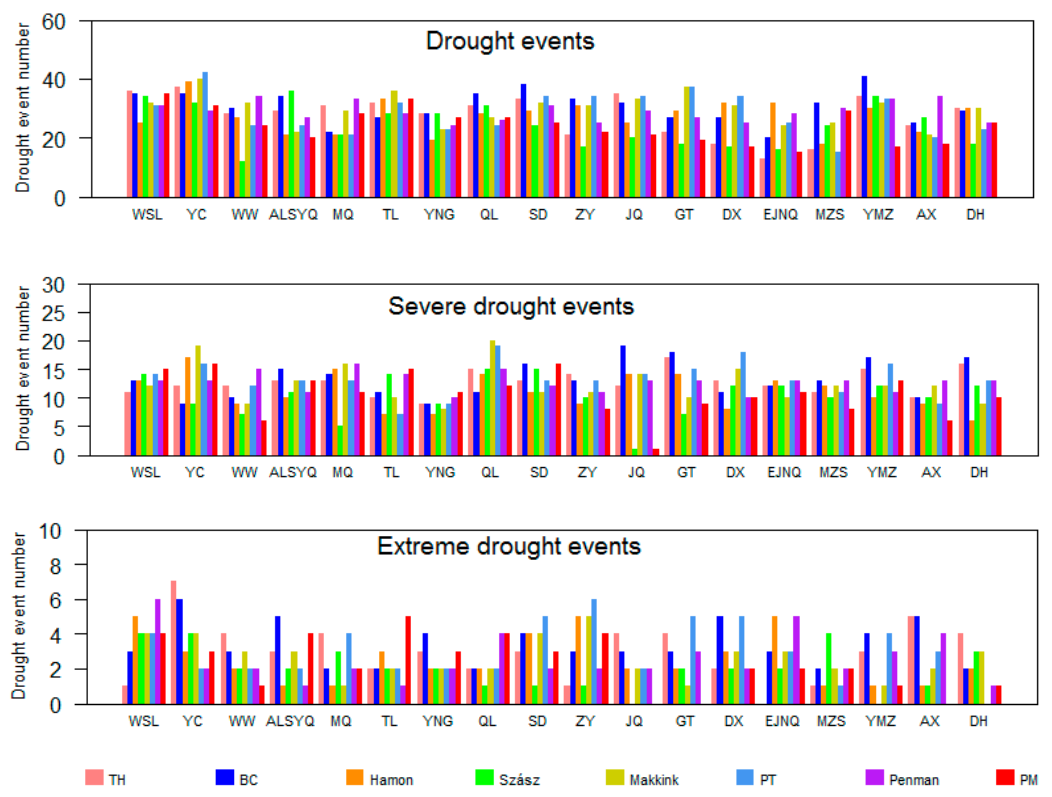
Figure 9. Numbers of drought events and different levels (extreme and severe) of the drought events at each